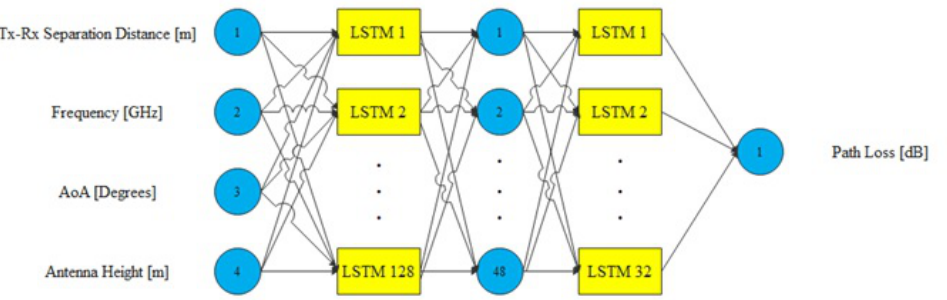
Figure 5. The architecture of the proposed RNN-LSTM